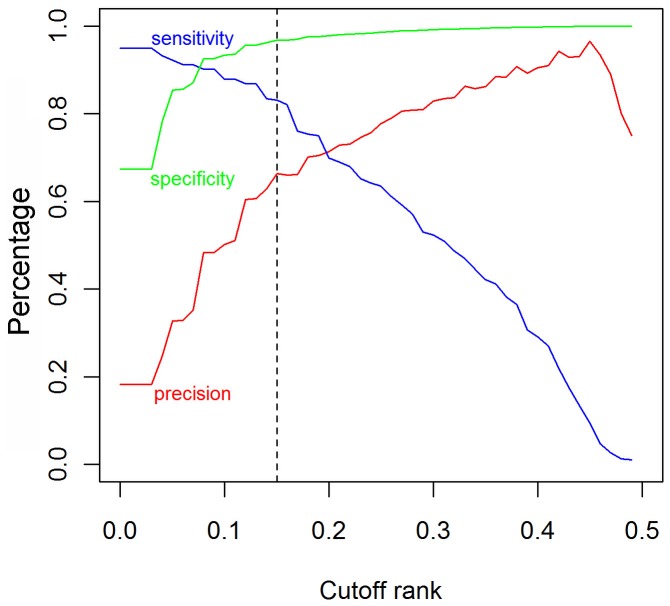
The precision, sensitivity and specificity in relation to the cutoff rank.The vertical dashed line represents the default cutoff of 0.15.